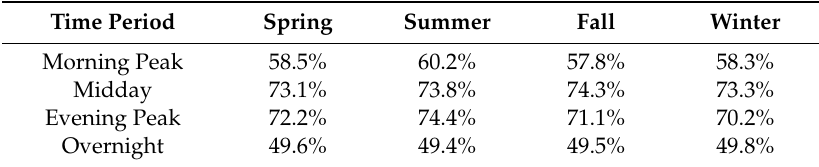
Table 2. Overall hourly average PM 2.5 concentrations increment due to considering resuspended dust compared with those of a network without resuspended